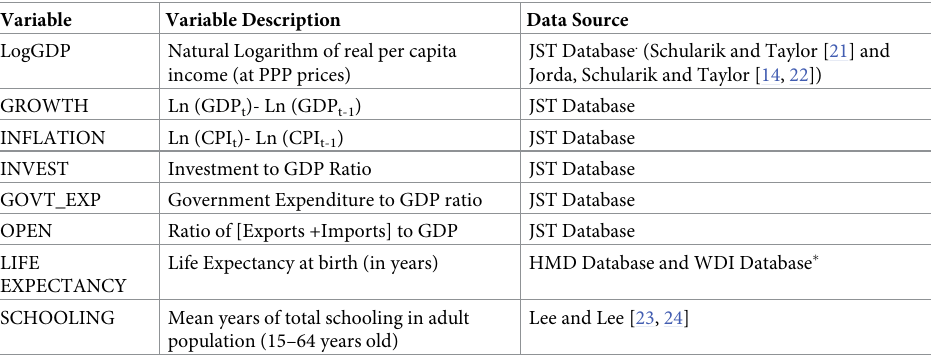
Table 1. Variable description and sources of